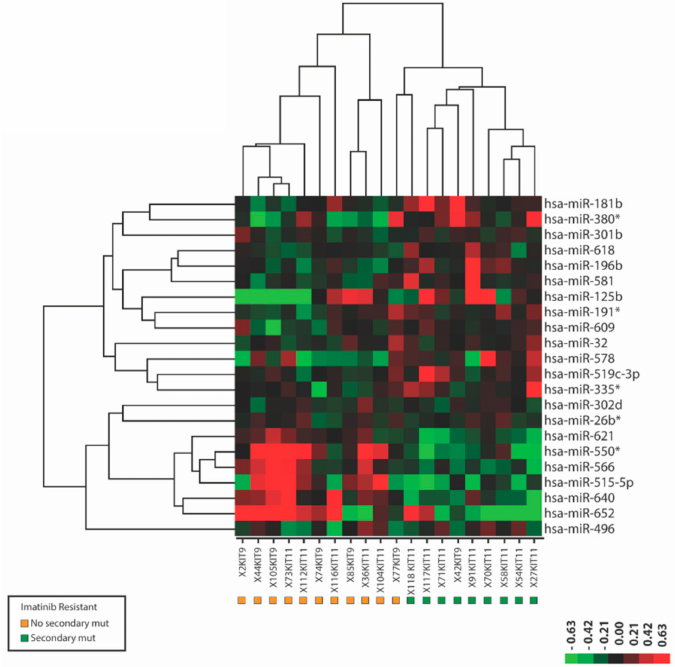
Figure 2. MicroRNAs di ff erentially expressed between imatinib-resistant gastrointestinal stromal tumor (GIST) samples with and without secondary mutations in KIT. Depicted is a heat map of a supervised hierarchical clustering based on the 22 most significant ( p < 0.01) di ff erentially expressed miRNAs in fresh frozen GIST samples with (green squares) and without (orange squares) secondary imatinib resistance causing mutations in KIT. In the heat map red indicates relative high expression and green indicates relative low expression. Note that the sample codes below also indicate which KIT exon is mutated.